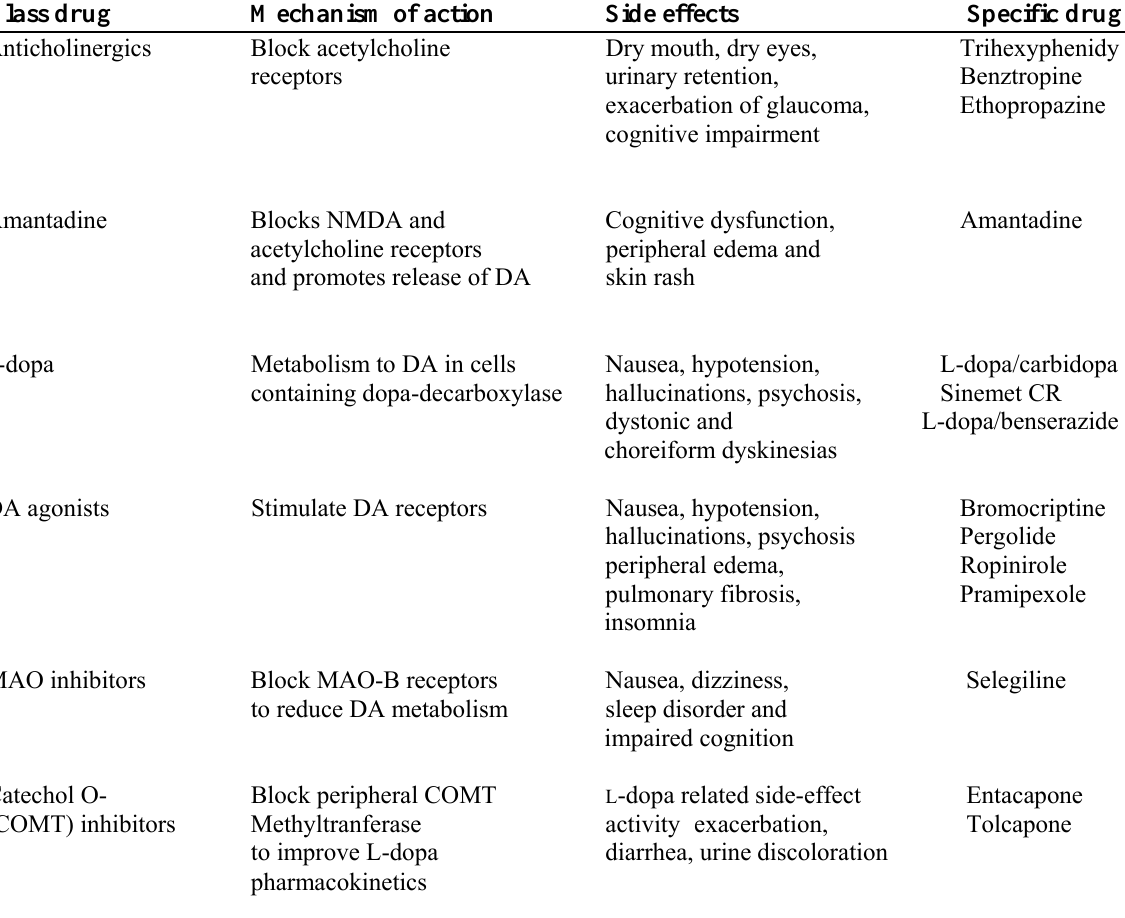
Table 1. Drugs used to treat Parkinson’s